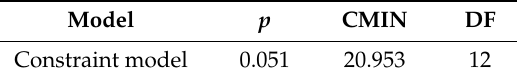
Table 7. Results of moderating e ff